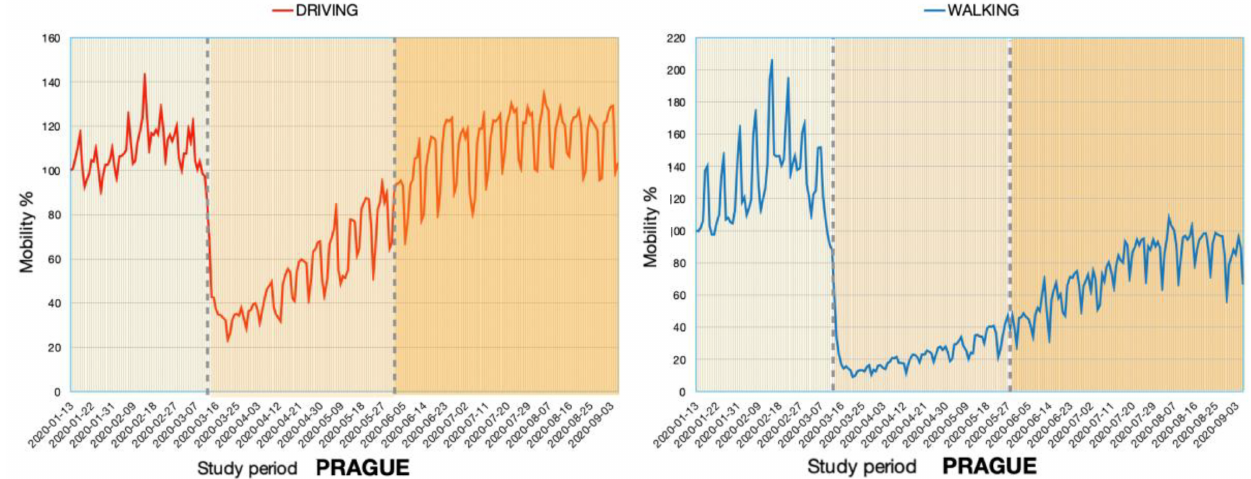
Figure 5. Mobility evolution in Prague from January until September 2020. Source: Own elaboration with data collected from Apple’s mobility trend [19].